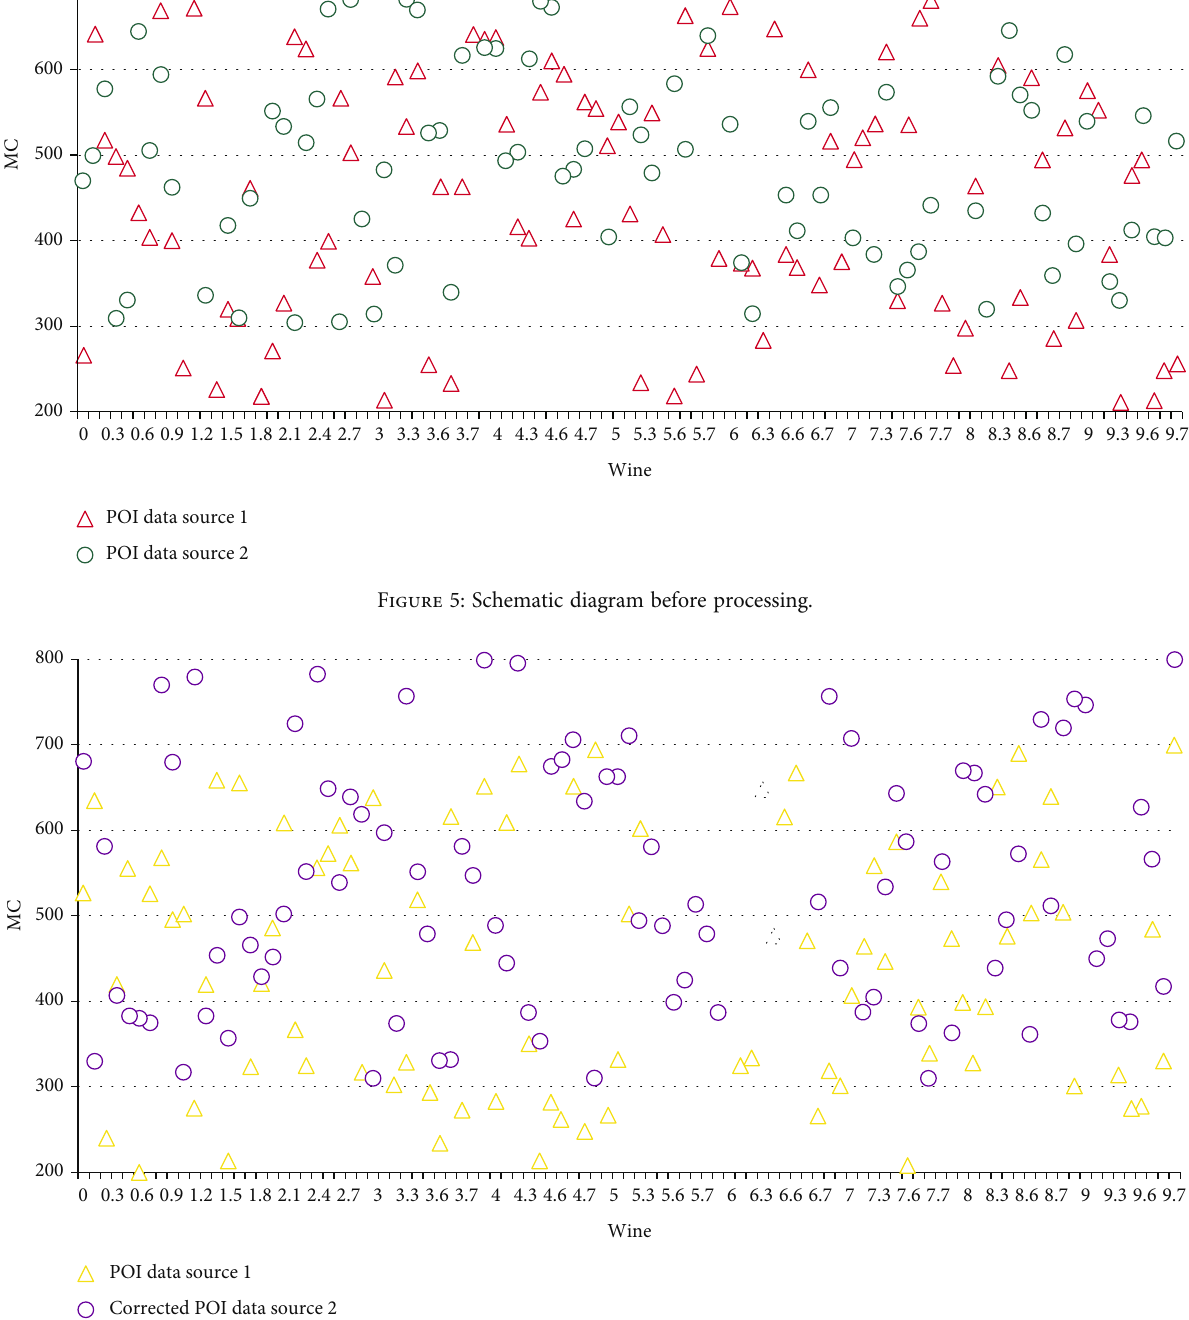
Figure 6: E ff ect after